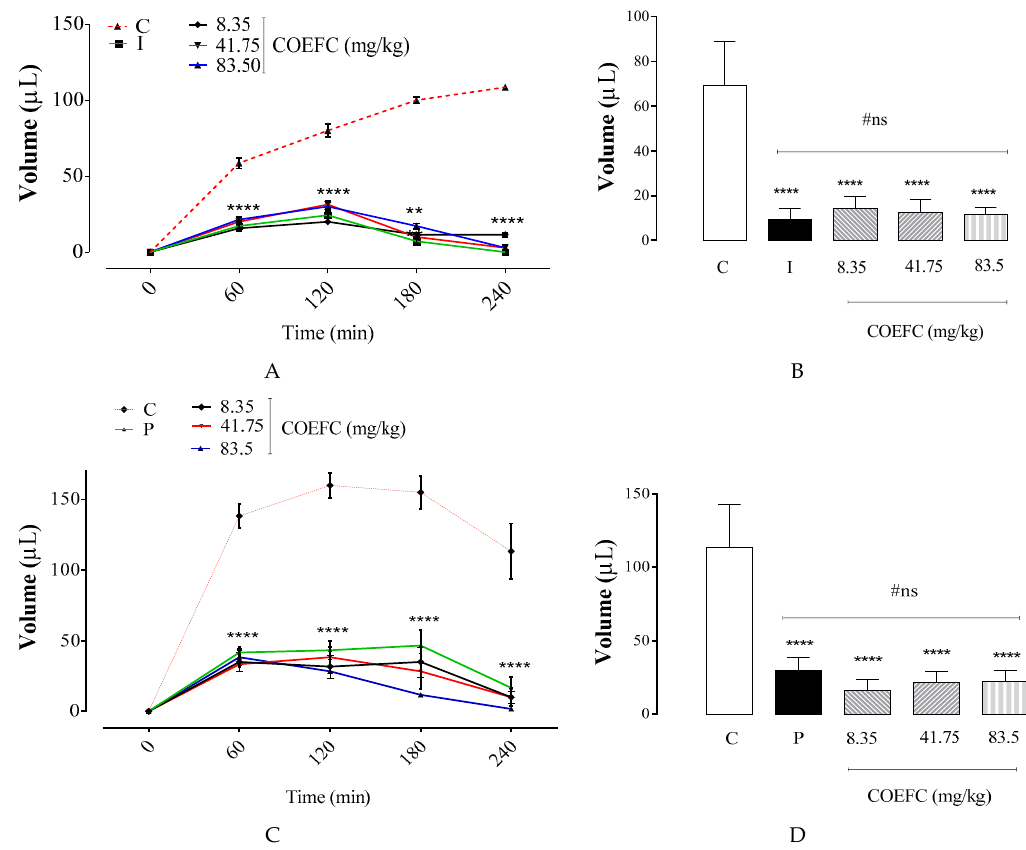
Figure 4. Effect of the COEFC (8.35, 41.75, and 83.5 mg/kg/p.o.) on paw edema induced by the intraplantar injection of 1% carrageenan and 1% dextran in mice. Paw edema induced by the intraplantar injection: ( A ) Edema value ( μ L) induced by carrageenan and ( C ) edema value ( μ L) induced by dextran 1%. ( B,D ) Results of the median paw volume ( μ L) at the 4th hour after the moment of application. Evaluation up to the 4th hour between the control groups (C) (saline 0.1 mL/10 g/v.o.), indomethacin (I) (10 mg/kg/s.c.), and COEFC (8.35, 41.75 and 83.5 mg/kg/p.o.). Values represent the mean ± S.P.M. ( n = 6/group). **** p < 0.0001 vs. control; Statistical analysis: ANOVA followed by the Dunnett’s test with multiple